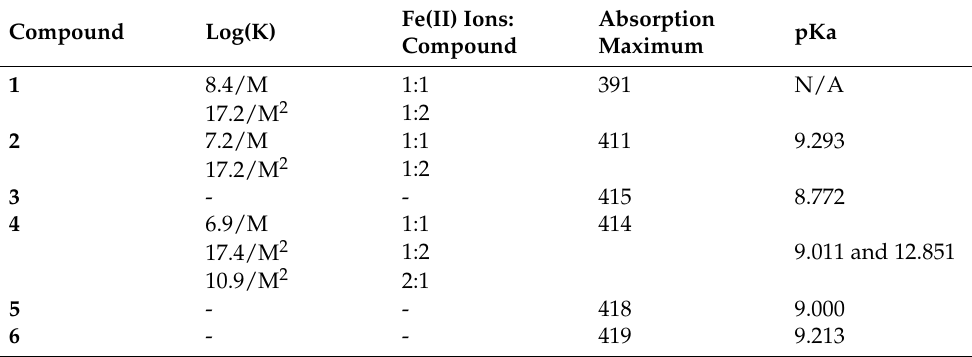
Table 1. Stoichiometry of compounds 1 – 6 with Fe(II) ions, their binding constants, absorption maxima, and